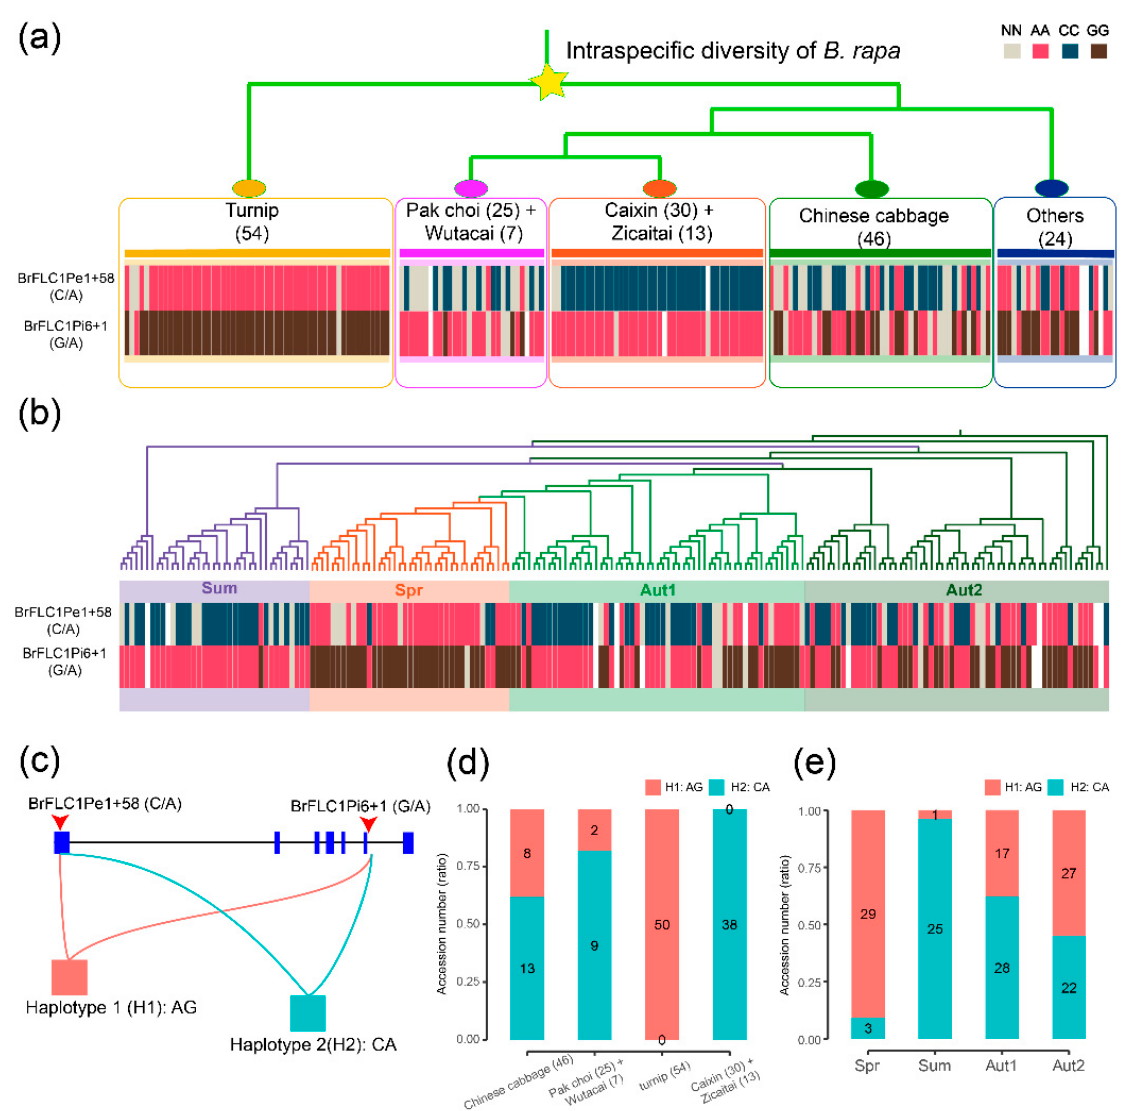
Figure 3. Distribution of haplotypes comprising BrFLC1Pe1+58 (A/C) and BrFLC1Pi6+1 (G/A) in different B. rapa subspecies. ( a ) Genotype distribution of BrFLC1Pe1+58 (A/C) and BrFLC1Pi6+1 (G/A) in a germplasm collection of 199 accessions [16]; ( b ) Genotype distribution of BrFLC1Pe1+58 (A/C) and BrFLC1Pi6+1 (G/A) in a collection of 192 Chinese cabbage accessions [18]; ( c ) Schematic model of haplotypes BrFLC1Pe1+58 (A/C) and BrFLC1Pi6+1 (G/A); ( d ) haplotype distribution in 120 of 199 B. rapa germplasm accessions; ( e ) haplotype distribution in 152 of 192 Chinese cabbage accessions. In ( d , e ), the accessions carrying heterozygous alleles in either BrFLC1Pe1+58 (A/C) or BrFLC1Pi6+1 (G/A) were not included.